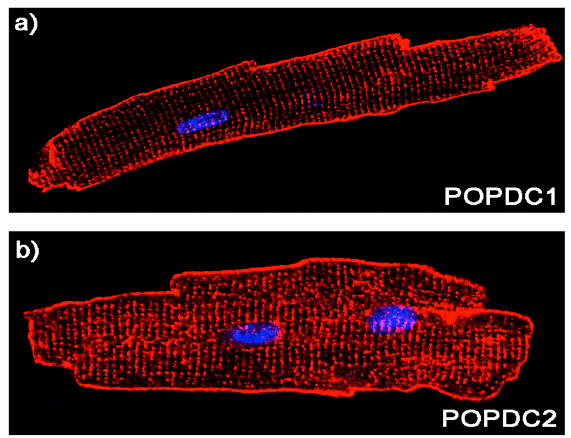
Figure 5. Expression of POPDC1 and POPDC2 in cardiac myocytes. Isolated adult cardiac myocytes were immunostained with ( a ) POPDC1 and ( b ) POPDC2 antibodies, respectively.